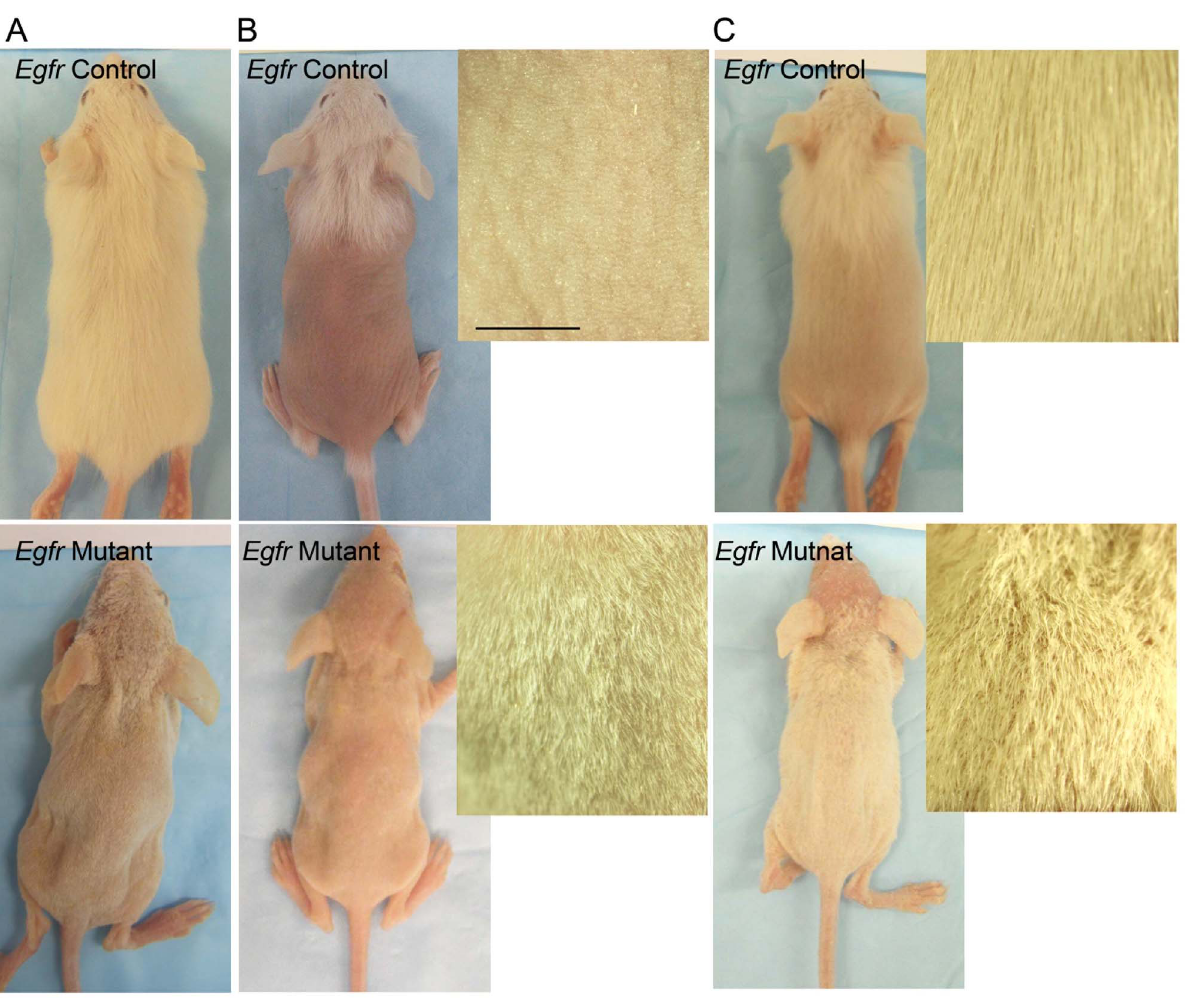
Figure 1. Egfr deficient hair follicles were resistant to cyclophosphamide-induced alopecia. Egfr mutant (bottom) and control mice (top) were injected with cyclophosphamide (B,C) or vehicle (A) alone and photographed 8d (A–B) or 15d (C) later. Insets, magnification of dorsal skin. Scale bar indicates 5 mm.